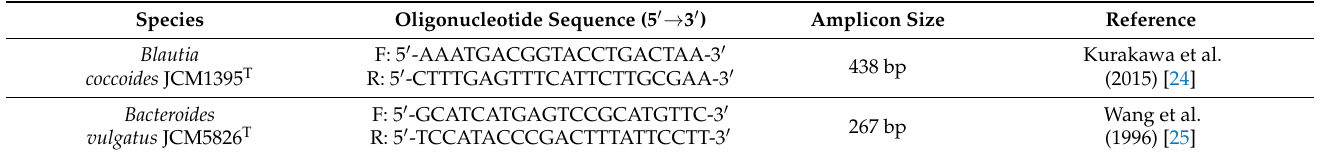
Table 1. List of 16S rRNA gene-targeted primers used in this